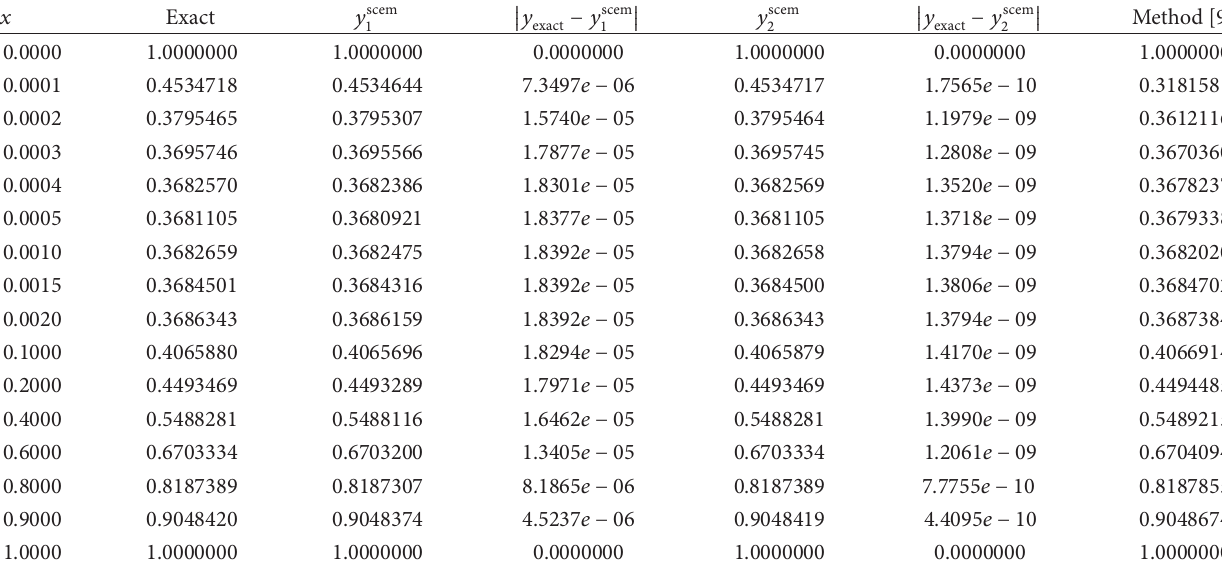
Table 2: Results of left layer problem for 𝜀 = 10 −4 and 𝛿 = 0.5𝜀